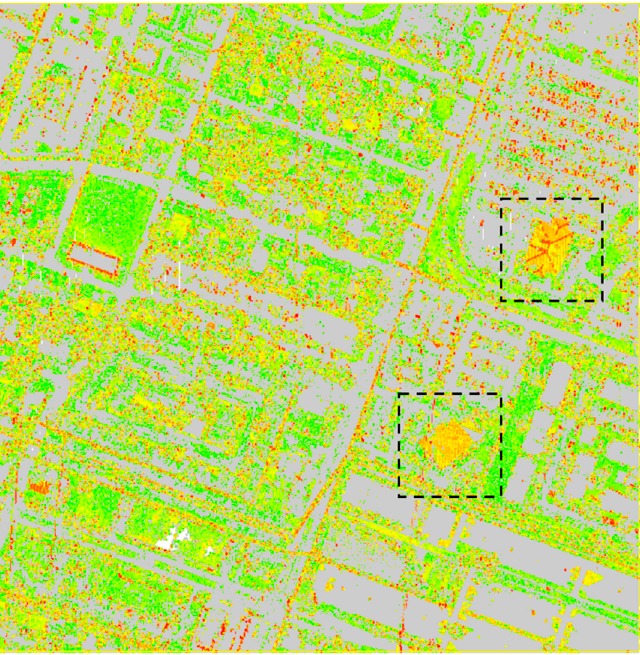
Figure 7. Calculated NDVI deviations. NDVI outliers are marked with black dashed boxes. Overall, the classification results from the three methods confirm the potential of multispectral LiDAR for land-use classification in complex urban landscapes. A comparison of the classification accuracy of the three methods is shown in Figure 8. The study area selected for the experiments covers a large area with complex land-use types, possessing various features and representative land-use categories. Using multispectral LiDAR to classify the area’s land use into roads, grass, buildings, trees, cars, and power lines, the method achieved an overall classification accuracy of 93.82%. The method, which